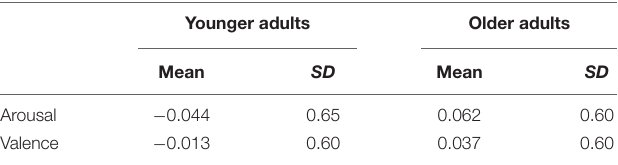
TABLE 2 | Mean arousal and valence ratings, with standard deviations, for the younger and older adults separately.